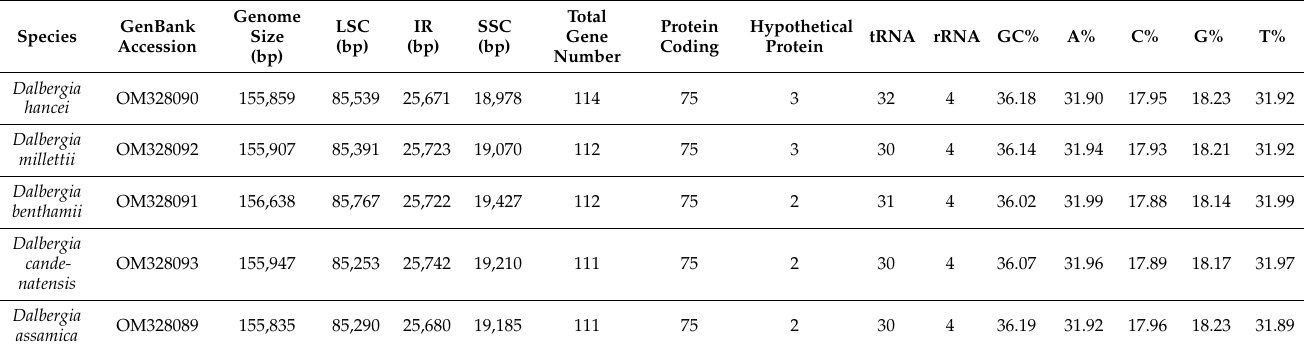
Table 1. Summary of the five Dalbergia chloroplast